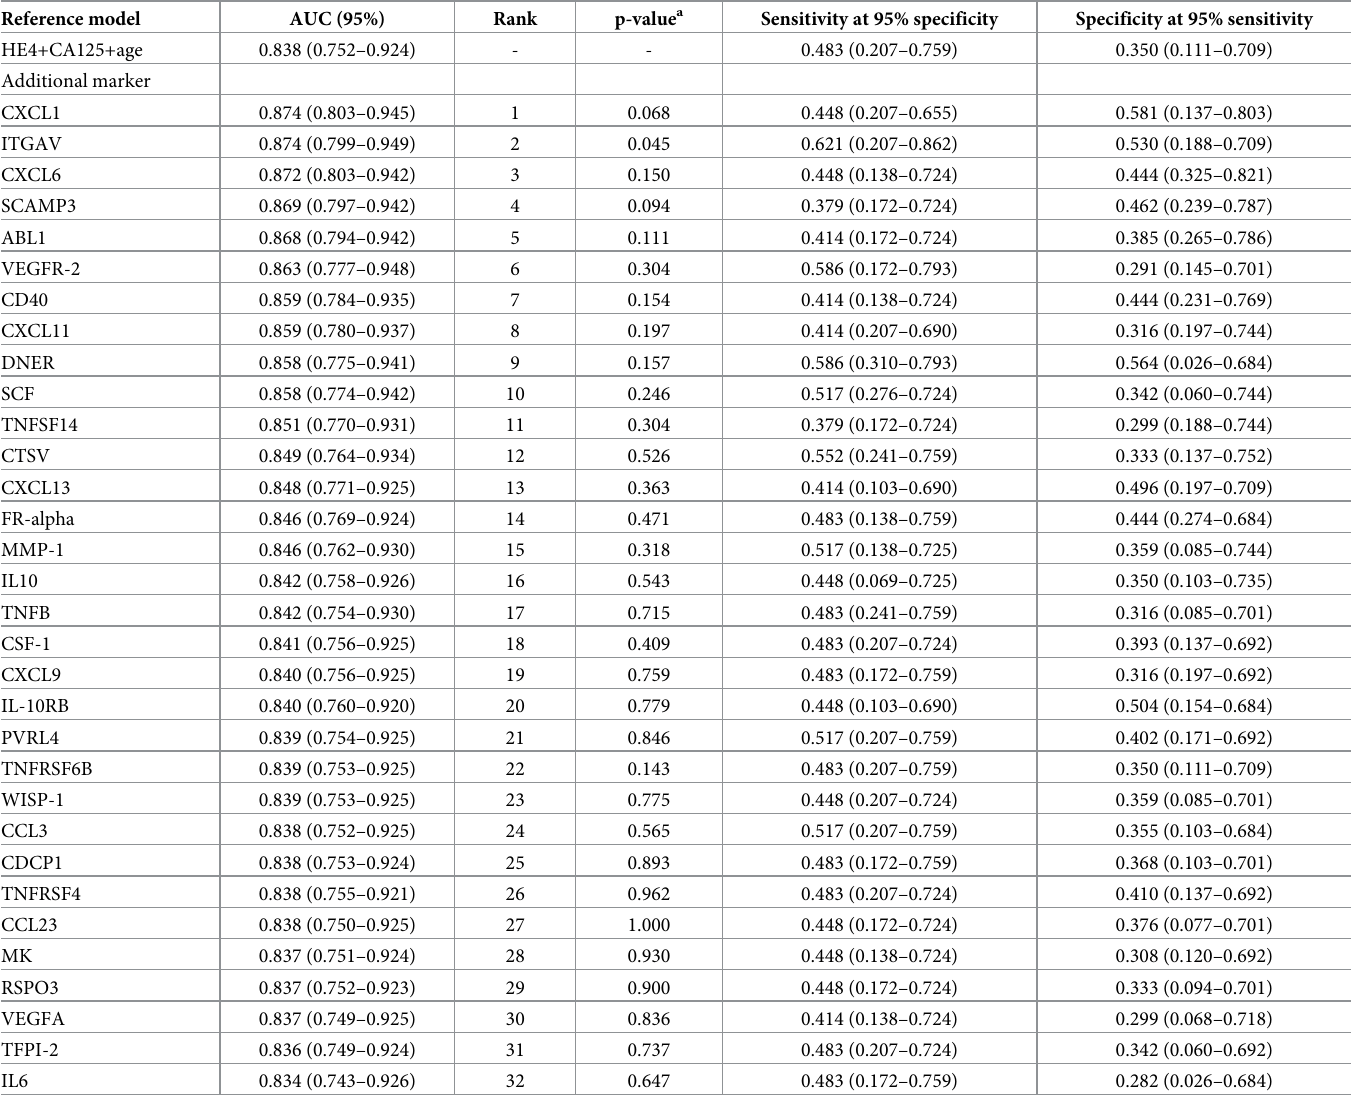
Table 4. Three-biomarker models. Benign tumors vs.